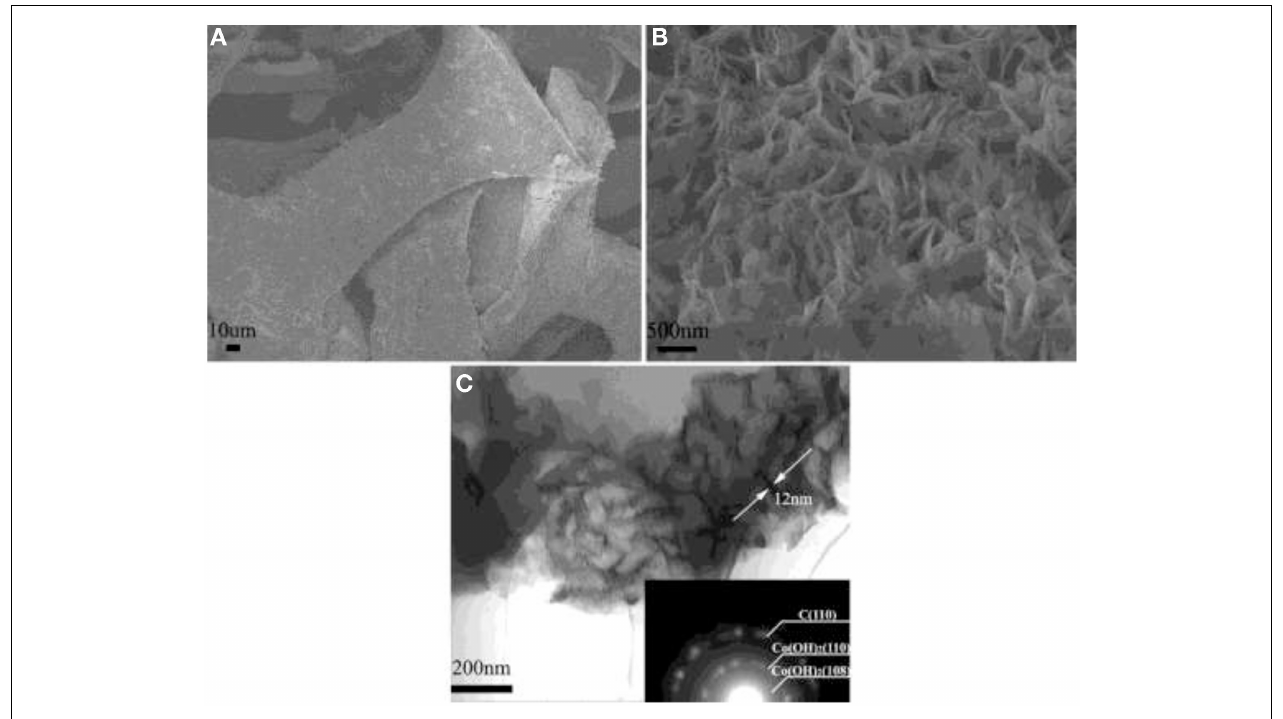
FIGURE 3 | (A,B) SEM images for Co(OH) 2 /GNS on Ni foam and (C) TEM images for Co(OH) 2 /GNS. Obtained from Zhao et al.